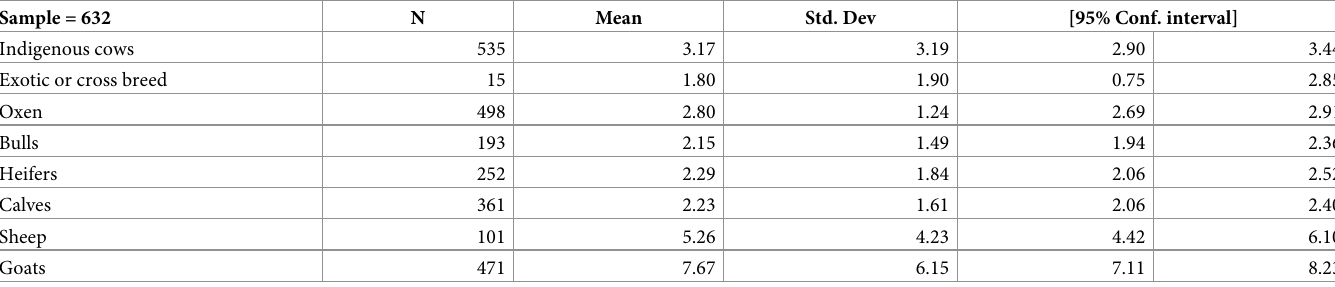
Table 2. Livestock ownership among the surveyed sample in Kwale County.